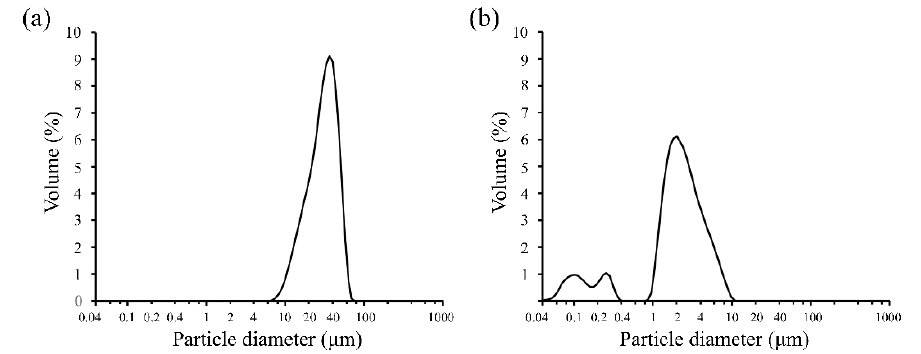
Figure 2. ( a ) powder size distribution of Incoenl 718 feedstock, and ( b ) NbC flakes.